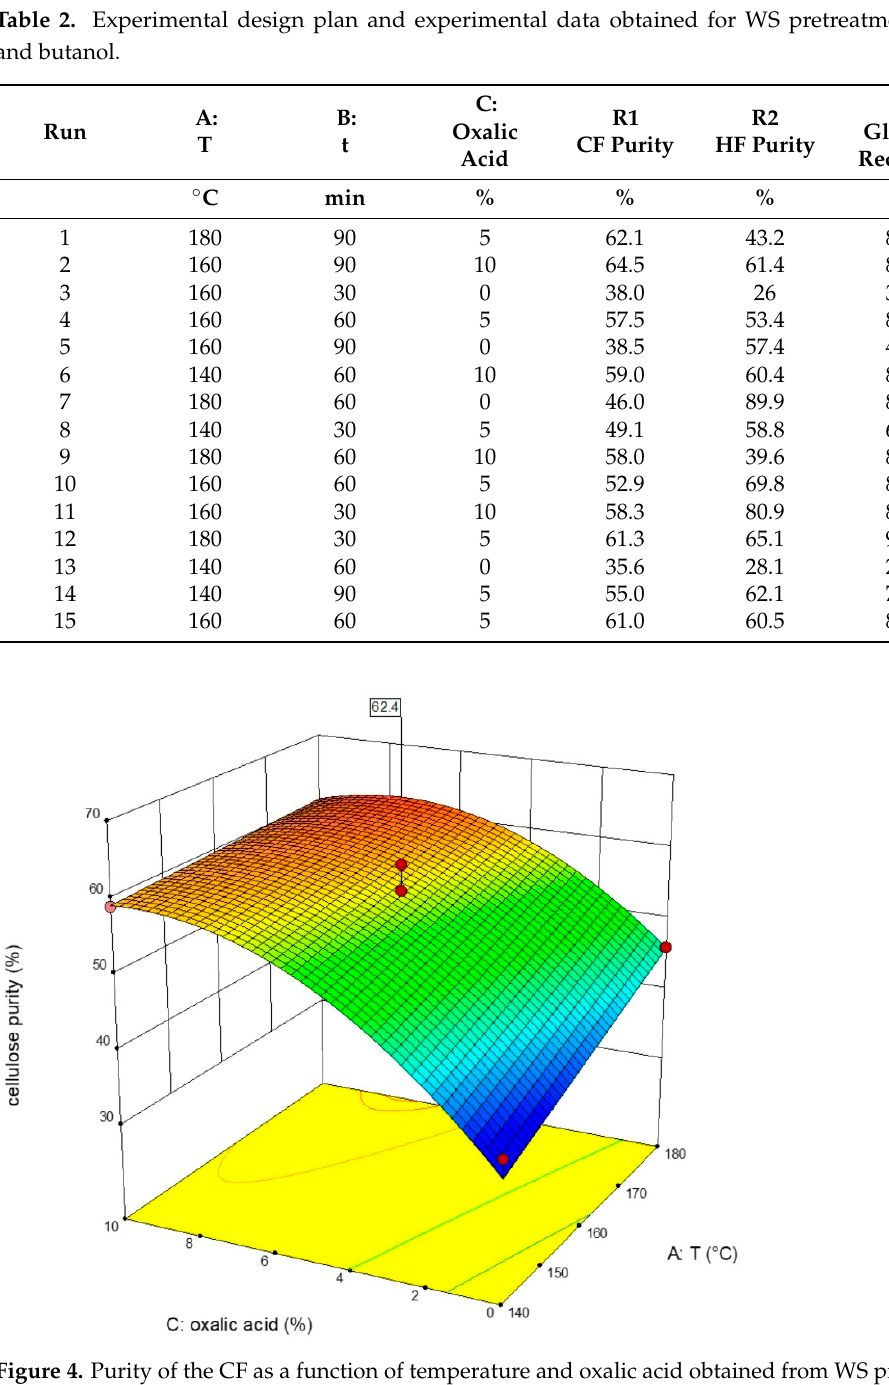
Figure 5. Purity of HF from WS pretreated with butanol as a function of temperature and oxalic acid (time = 90 min).